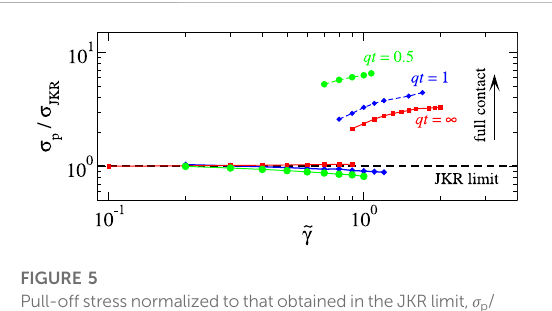
Pull-offstressnormalizedtothatobtainedintheJKRlimit, σ p / ~ γ with the elastic σ JKR , as a function of the reduced surface energy layer thickness qt — 0.5, 1, and ∞ . The dashed black line indicates the JKR limit. The fl at, low σ p lines correspond to JKR-like snap-off, while the curved, high σ p re fl ects saddle-point instabilities. Endpoints of qt = 0.5, 1, and ∞ are located at ~ γ